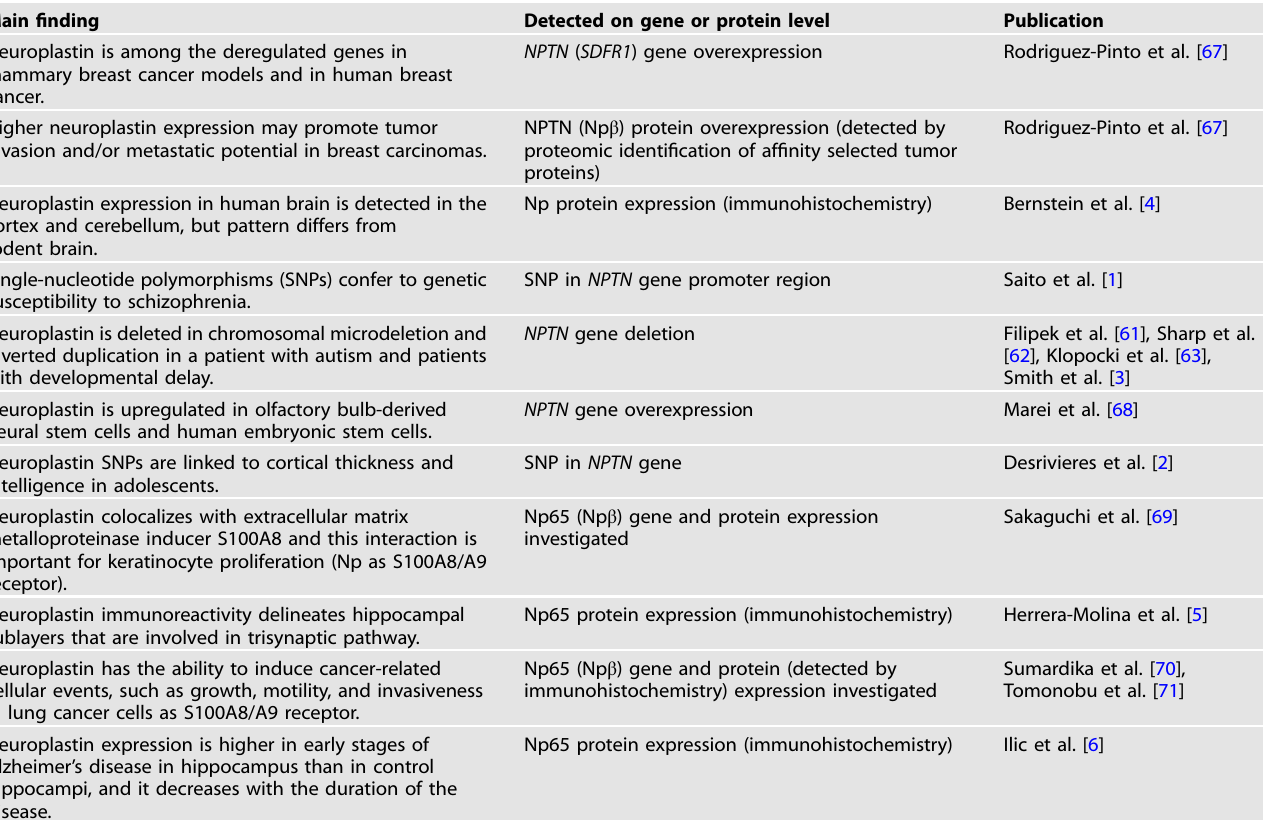
Table 2. Neuroplastin in human